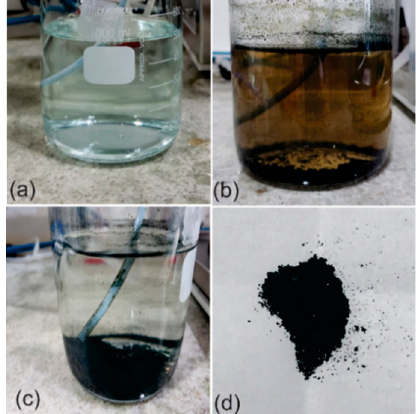
Figure 2. Transitional copper stages during Acid Mine Drainage (AMD) sample exposure to biogenic